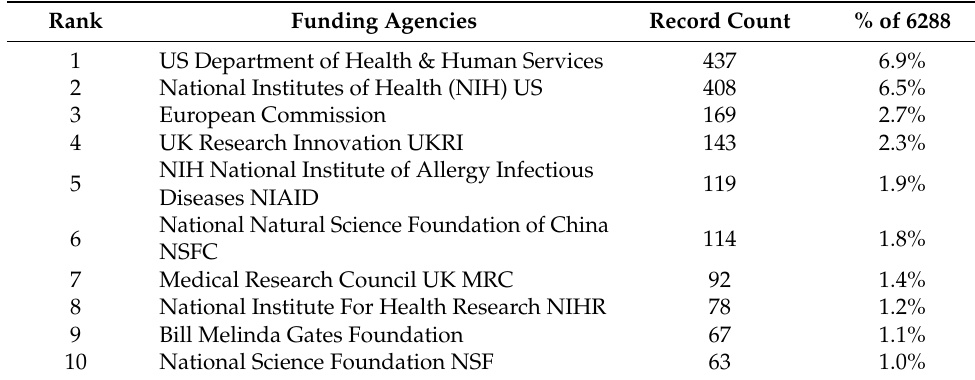
Table 5. Active funding agencies in COVID-19 vaccine